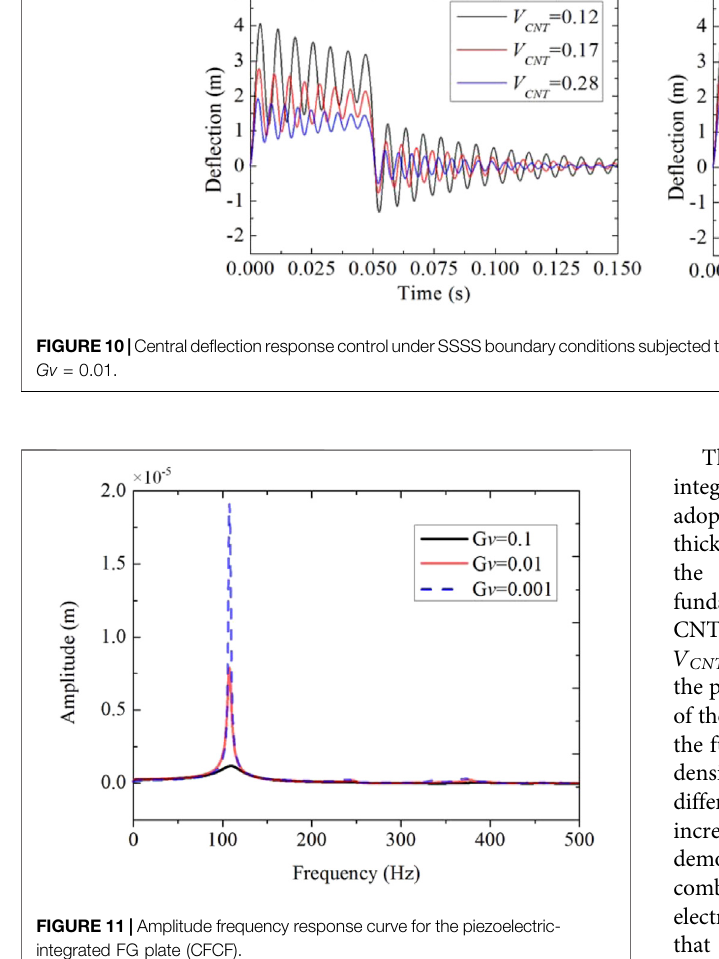
Frontiers in Materials |